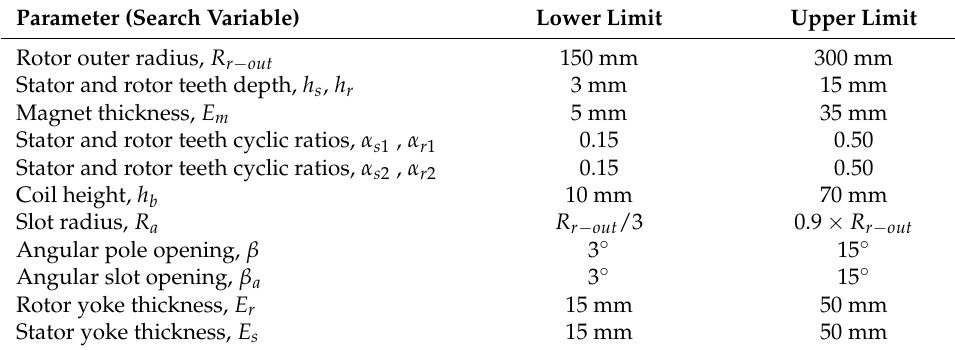
Table 2. Range of optimization